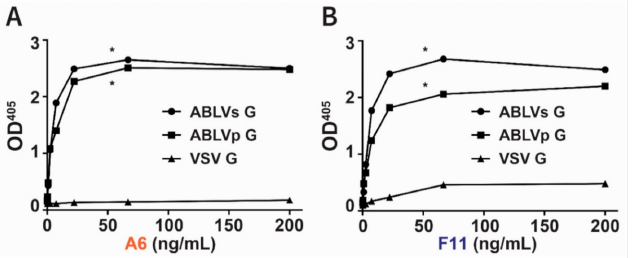
Figure 2. Direct binding of anti-ABLVs G hmAbs to the glycoproteins of ABLVs and ABLVp. The binding of hmAbs ( A ) A6 and ( B ) F11 to ABLVs G (circle), ABLVp G (square), and VSV G (triangle) was quantified using ELISA. The average value from duplicate wells is shown. * p < 0.05, one-way ANOVA with Dunnett’s multiple